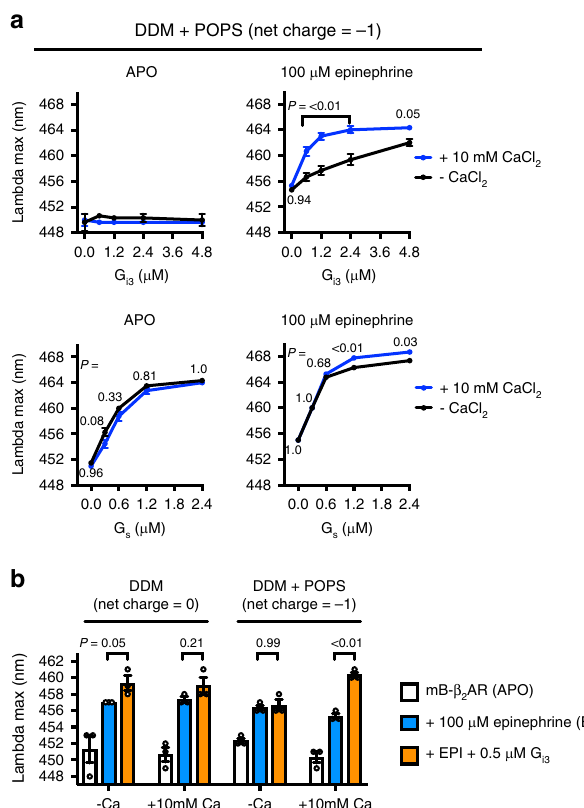
Fig. 2 Ca 2 + facilitates G i3 coupling in negatively charged phosphatidylserine. a The effect of 10 mM CaCl 2 on mB − β 2 AR − G protein interaction (G i3 and G s ) was examined in micelles containing 5:1 DDM: POPS (mole ratio). Data were collected in the absence (APO) and presence (100 μ M) of epinephrine. mB − β 2 AR concentration is 250 nM. Data are mean ± s.e.m. of three independent experiments. Multiplicity adjusted P values were computed by two-way ANOVA followed by Sidak ’ s post hoc test between CaCl 2 conditions. b The effect of 10 mM CaCl 2 on mB − β 2 AR − G i3 interaction in DDM micelles± POPS (i.e. DDM alone vs. 2.5:1 DDM: POPS mole ratio). mB − β 2 AR concentration is 250 nM. Data are mean ±